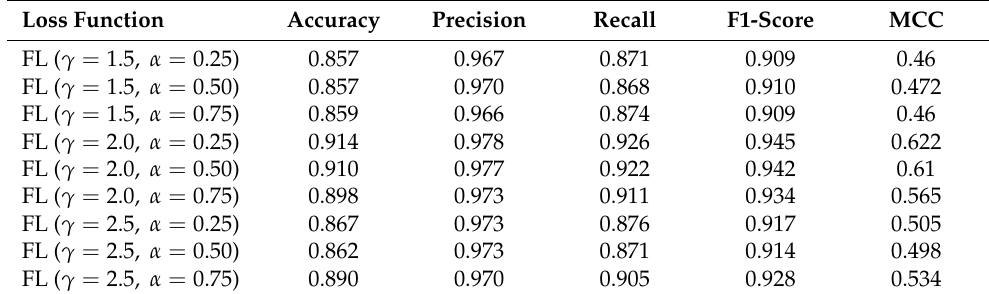
Table 7. Classification results with HSI-10 dataset for varying cost functions and respective parameter sets. (patch size parameter S = 100, 3D convolutions, see Figure A2 for network topology).